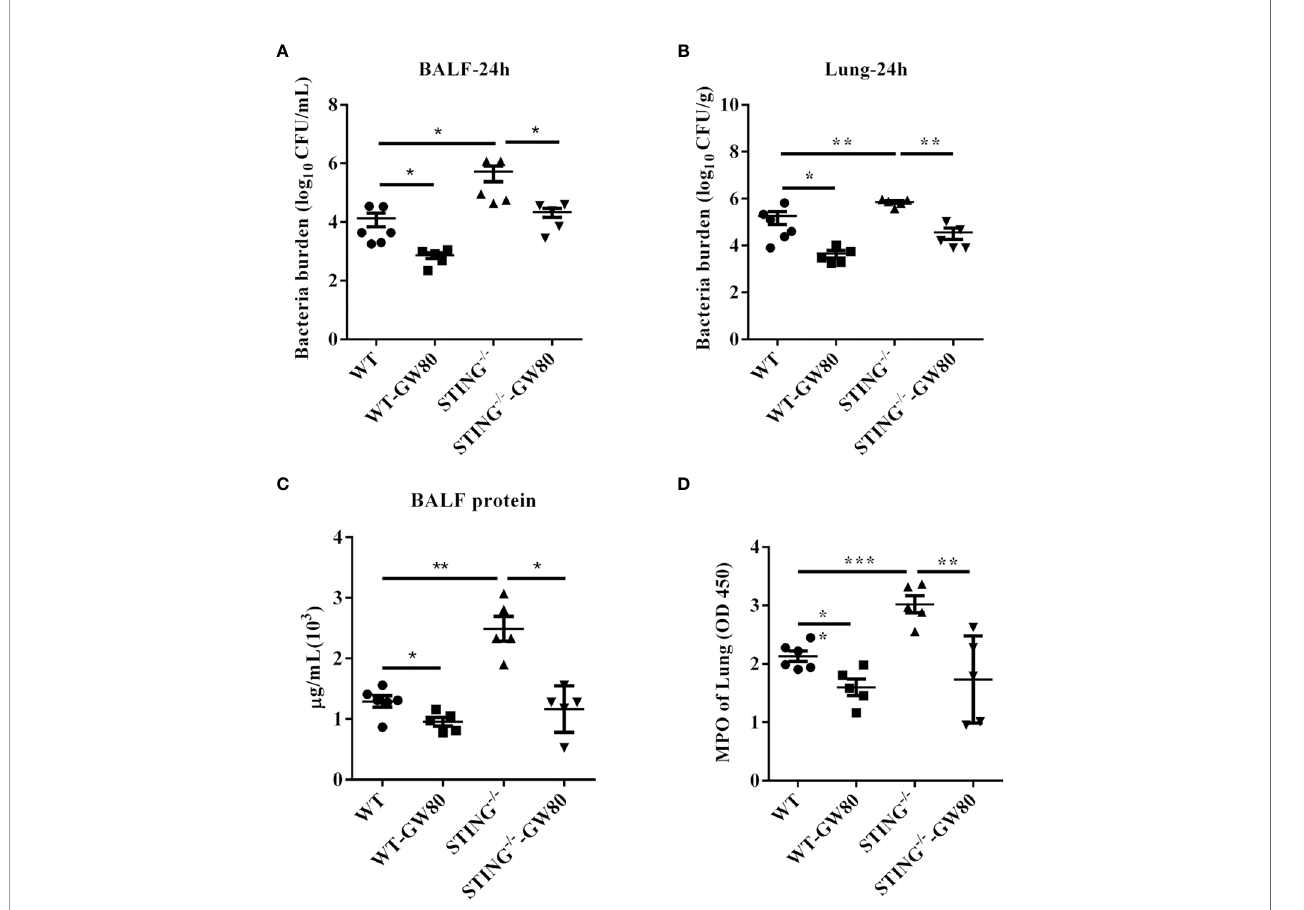
FIGURE 7 | Blocking necroptosis in STING -/- mice improves host defense during S.aureus infection. For one group of WT and STING -/- mice, 100 m L of 100 m M GW806742X was injected intraperitoneally 12 h and 1 h prior to infection with S.aureus (1 × 10 8 CFU/mouse). Mice were euthanized at 24 hpi to quantitate the bacterial burden in (A) BALF, (B) lung. (C) Total protein in BALF was measured. (D) The homogenate supernatant of the lung was also used to determine the activity of MPO. All data are shown as mean ± SEM. One-way ANOVA with Bonferroni ’ s multiple comparison test was performed. Statistical signi fi cance is indicated by *p < 0.05, **p < 0.01, and ***p <